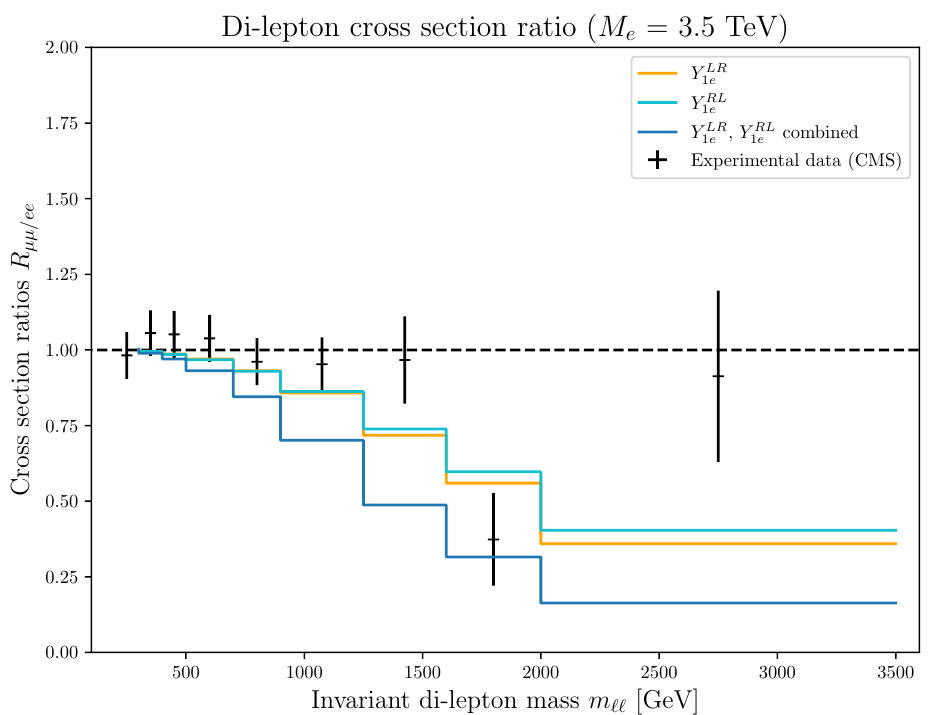
Figure 10. The resulting values R for an electroquark extension of the SM with Y LR